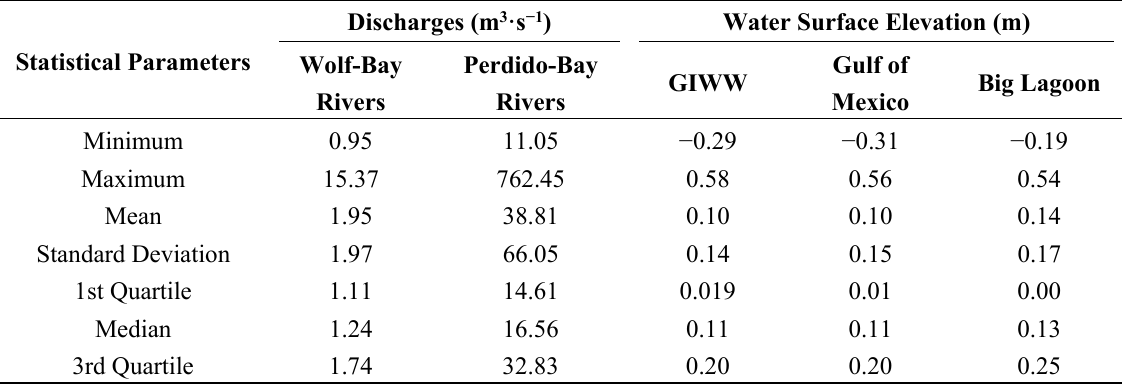
Table 1. Statistical summary of river inflows into Wolf Bay and Perdido Bay and filtered water surface elevations at GIWW (Gulf Intracoastal Waterway, west boundary), the Gulf of Mexico (south boundary), and Big Lagoon (east